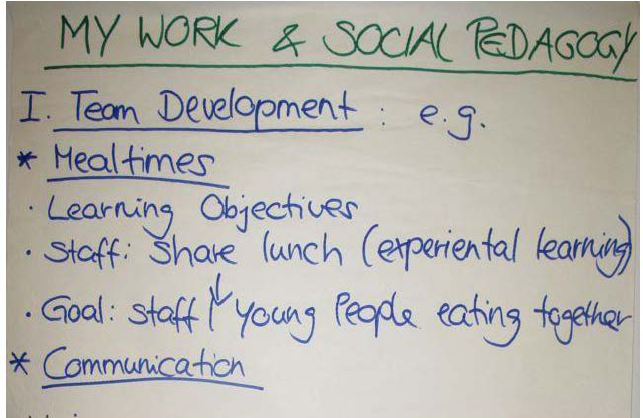
Figure 1. My work and social pedagogy (Cameron et al., 2011, p.